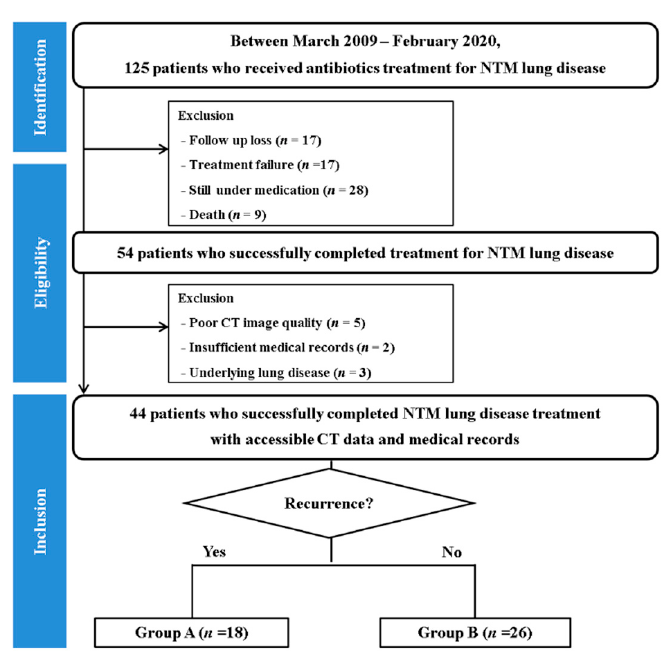
Figure 1. Flowchart of patient